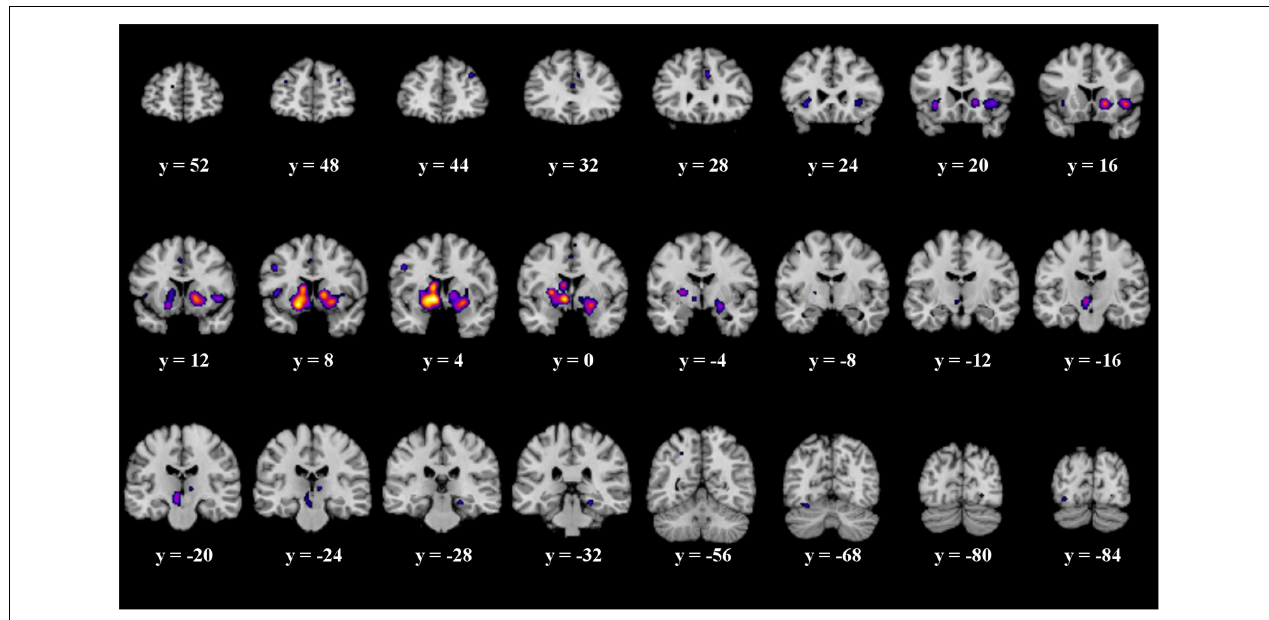
FIGURE 2 | Overview of the meta-analysis results for all studies ( p < 0.05, FDR). The significant clusters are comprised of activity in the superior frontal gyrus, middle frontal gyrus, anterior cingulate, cingulate gyrus, claustrum, insula, caudate head, precentral gyrus, putamen, lateral globus pallidus, caudate body, red nucleus, thalamus, parahippocampal gyrus, superior parietal lobule, declive, lingual gyrus and the fusiform gyrus (from left to right). MNI coordinates are presented below each coronal